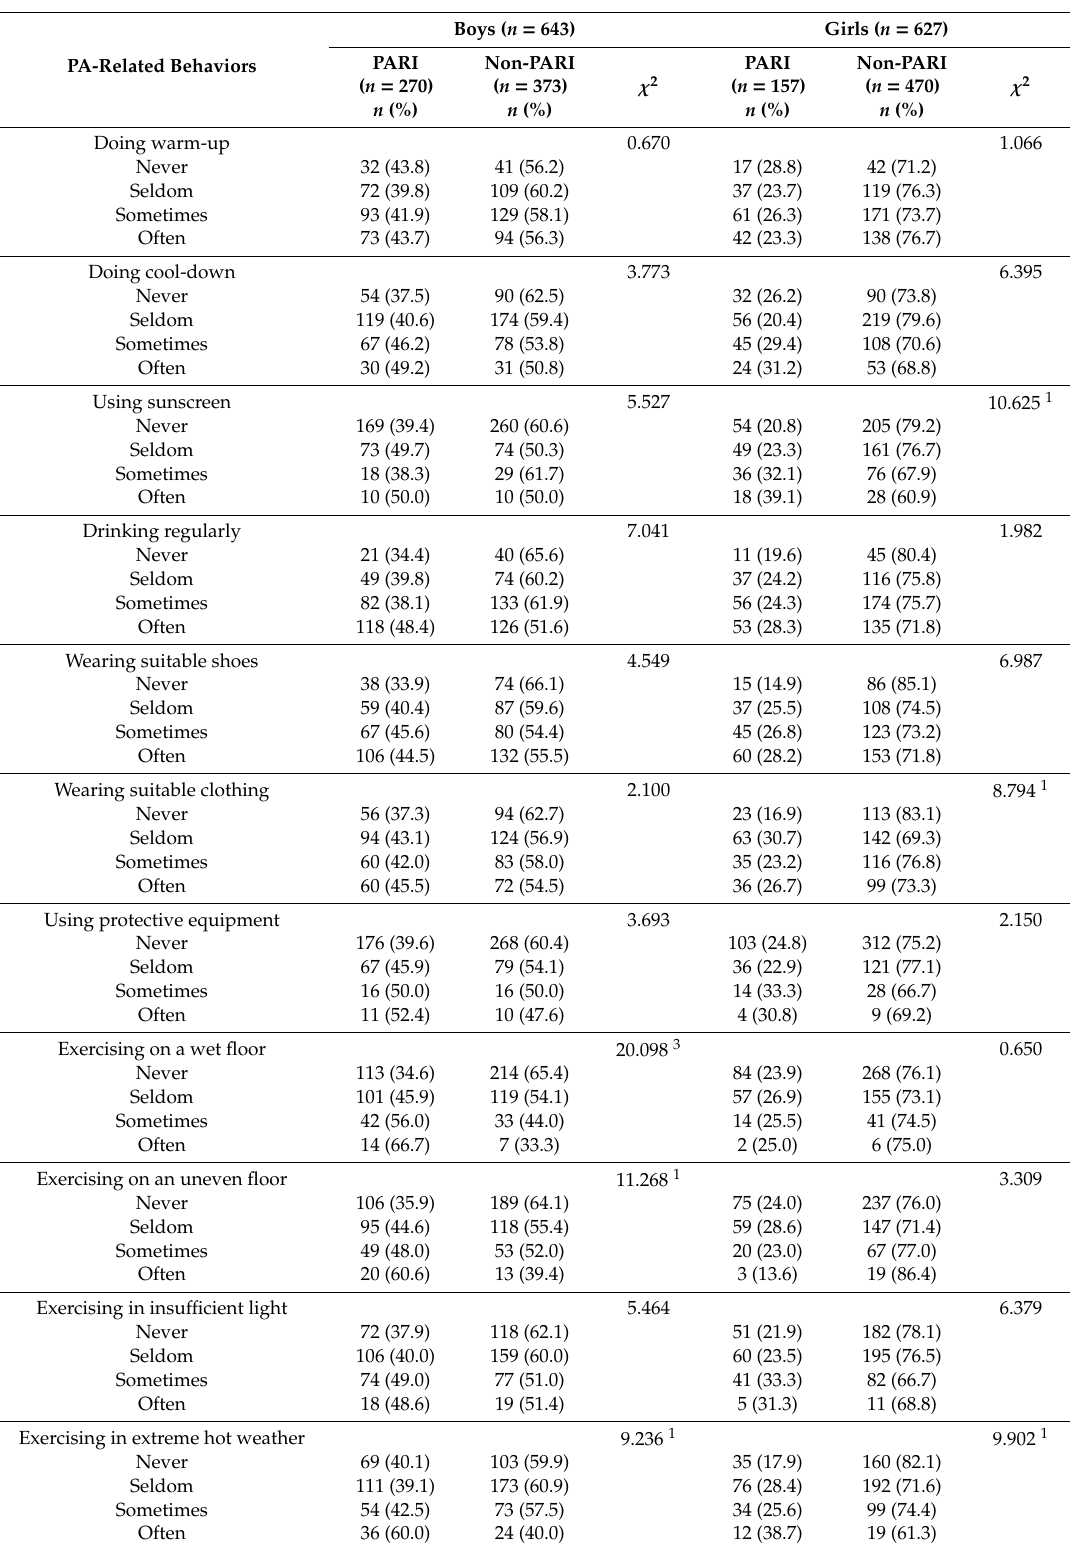
Table 2. Comparison of physical activity (PA)-related behaviors in physical activity-related injuries (PARI) and non-PARI group among di ff erent